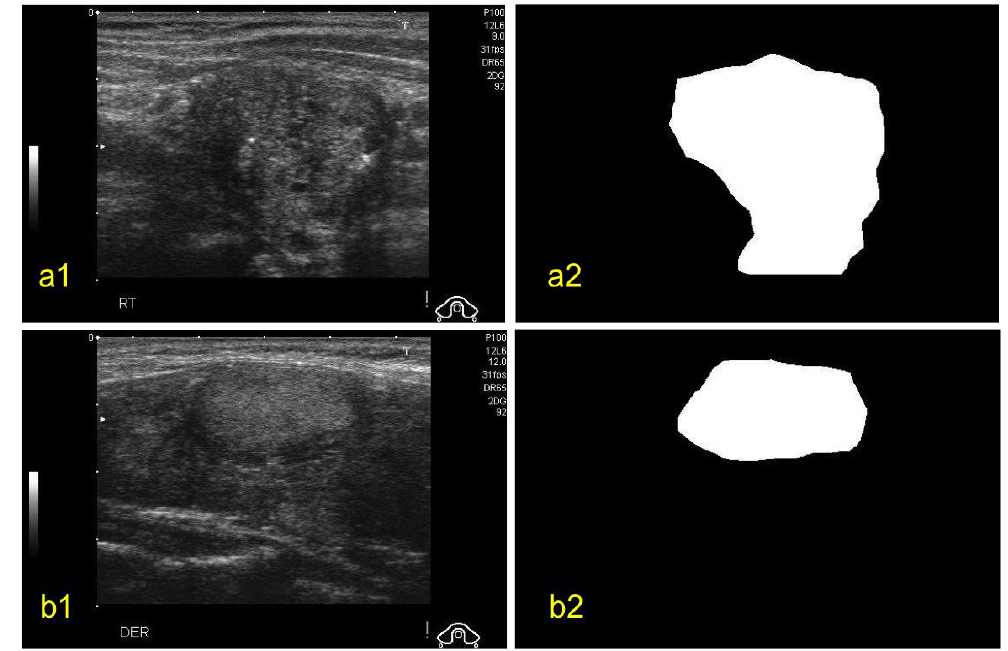
Figure 2. Examples of ultrasound images of thyroid nodules ( a1 ) malignant nodule, ( a2 ) its ground truth, ( b1 ) benign nodule and ( b2 ) its ground truth [19].